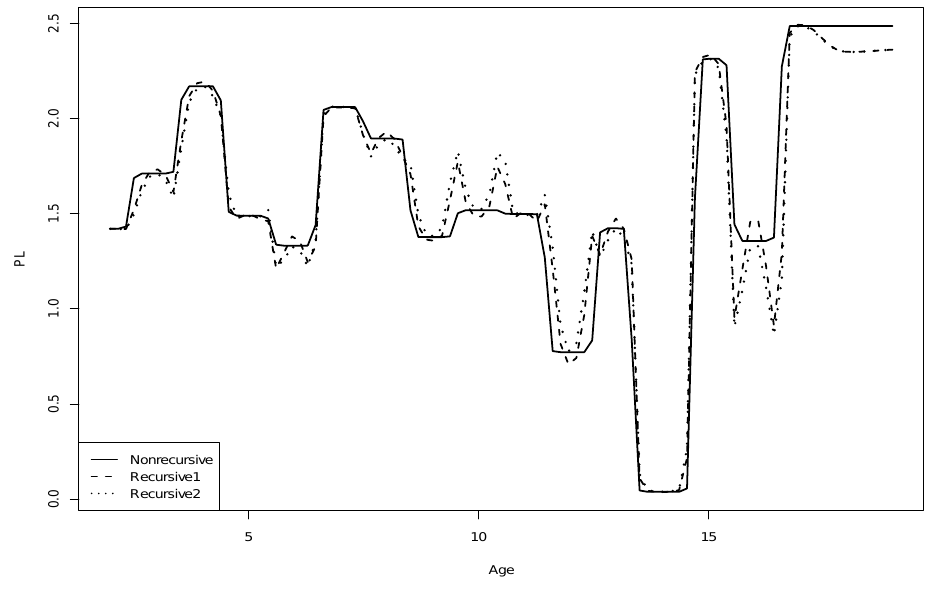
Figure 3: The Plasmodium falciparum Parasite Load density with automatically bandwidth selection using the Non-recursive correspond to the estimator (5) using the proposed plug-in bandwidth selection (17), Recursive 1 correspond to the estima- tor (4) using the proposed plug-in bandwidth selection (14) and the stepsize ( γ n ) = (cid:0) n −1 (cid:1) , Recursive 2 correspond to the estimator (4) using the proposed plug-in bandwidth selection (14) and the stepsize ( γ n ) = (cid:0) h n / (cid:2)(cid:80) n